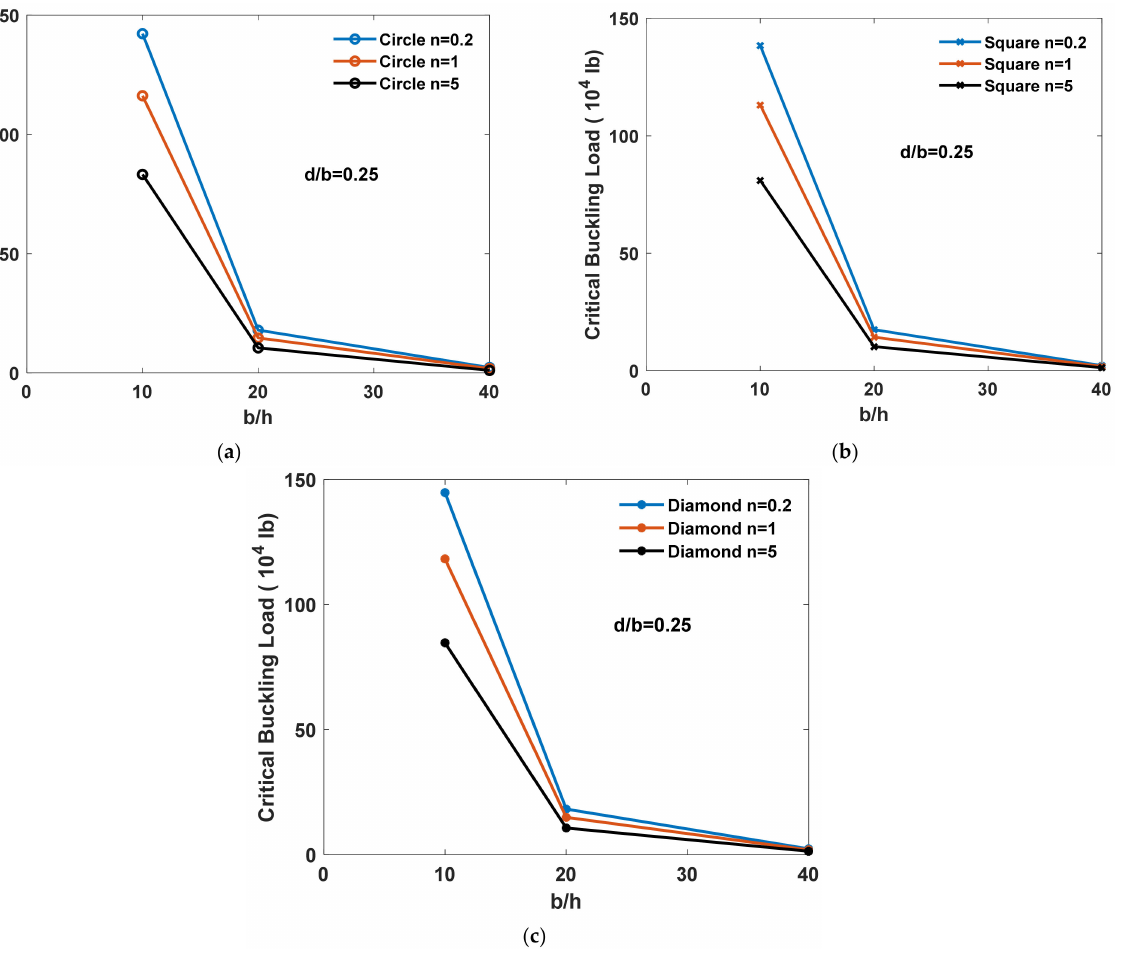
Figure 9. The variation of the aspect ratio on the critical buckling load for ( a ) circle, ( b ) square, and ( c ) diamond openings for an aspect ratio d/b =